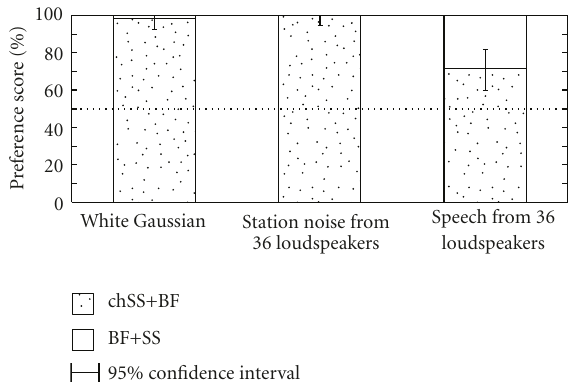
Figure 21: Subjective evaluation